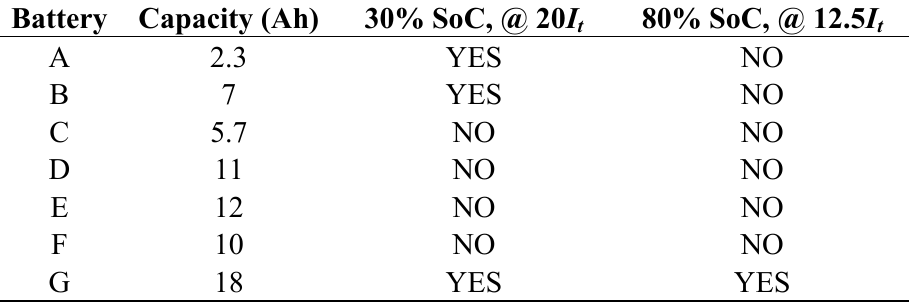
Table 5. Charge and discharge capabilities at 30 and 80% SoC.